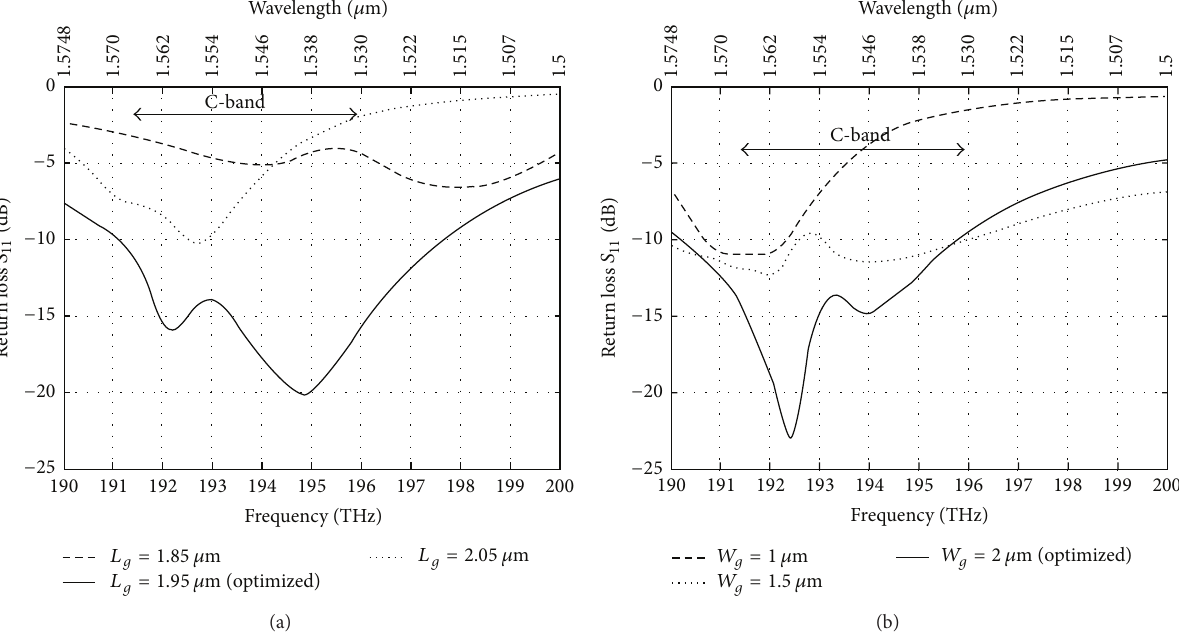
Figure 3: (a) Length of partial ground plane with optimized values. (b) Width of partial ground plane with optimized values.